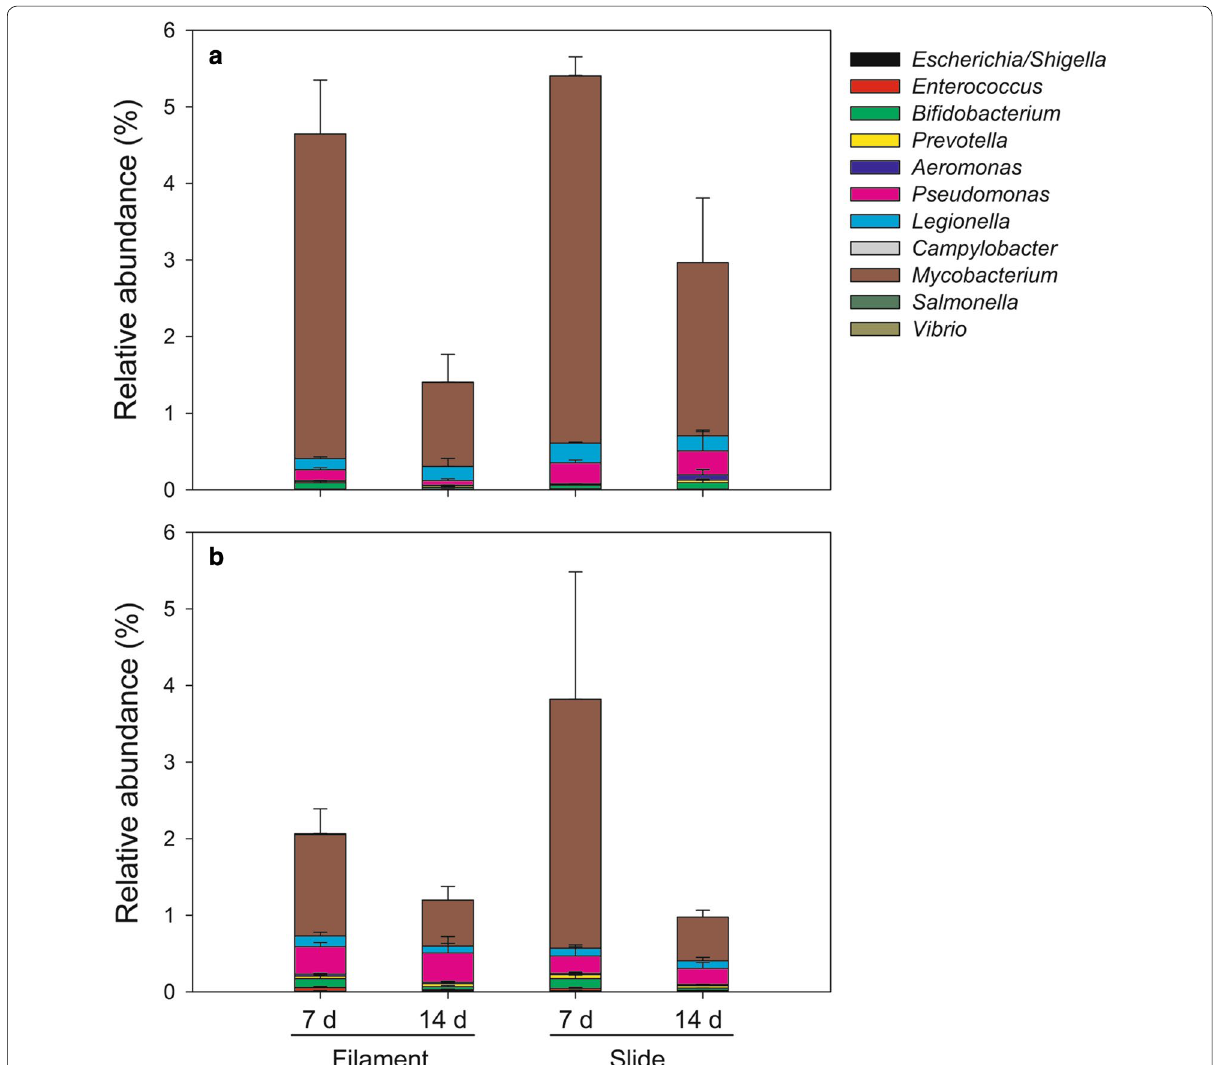
Fig. 5 The effects of sampling time, site and substrate type on the genera of fecal indicator bacteria and pathogens in microbial community attached to artificial substrates. a Site A lentic; b Site B = =